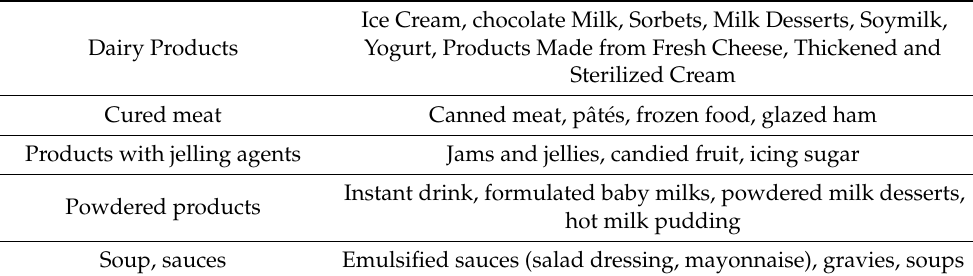
Table 2. Products containing carrageenan—Adapted from Tarlo et al., 1995